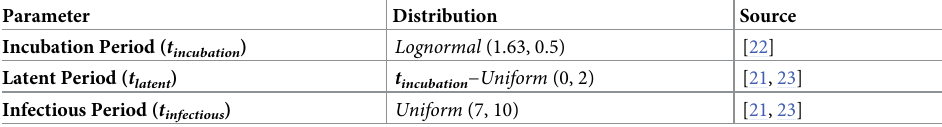
Table 1. Distributions and parameter values used in analytic framework and model simulations. The latent period is defined as the time between exposure and onset of infectiousness, the incubation period as the time between expo- sure and both symptoms and peak infectiousness (even in the absence of symptoms), and the infectious period as the total time a case is